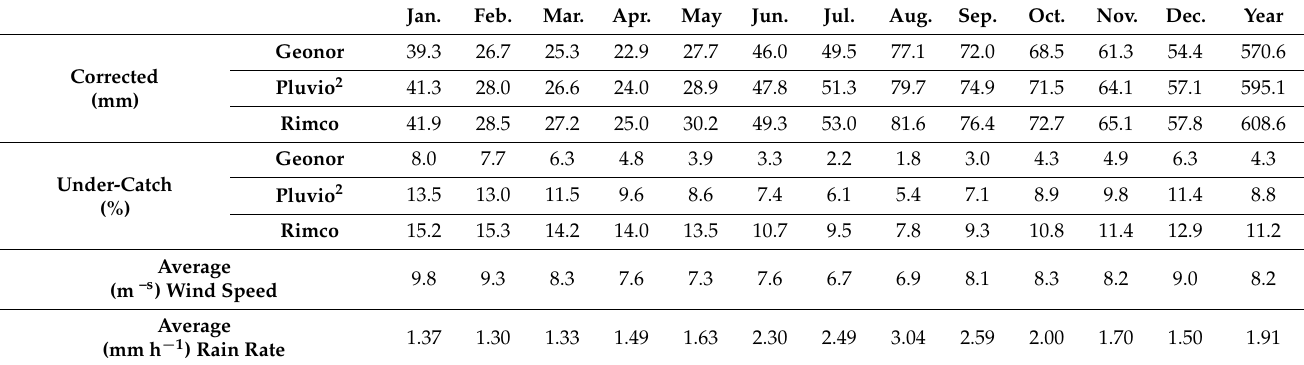
Table 4. Correction on rain amount per month and yearly average at Hvide Sande for three rain gauge types: Geonor, Pluvio 2 , and Rimco. Average wind speed during precipitation and average measured rain rate are